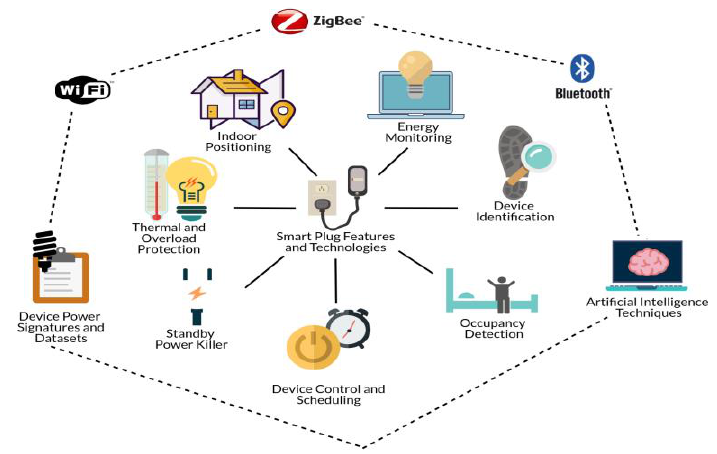
Figure 1. Features and Technologies used in the smart plug.